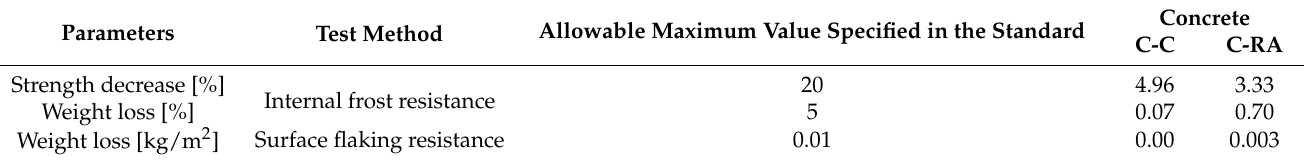
Table 12. Resistance of C-C and C-RA series of concretes to frost resistance cycles. Parameters Test Method